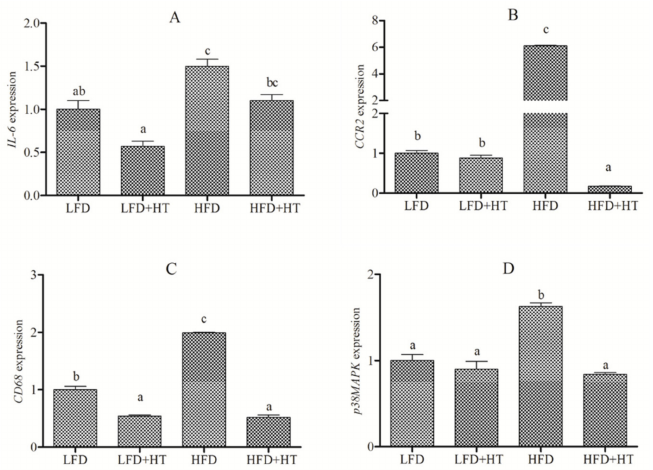
Figure 5. Relative expression of inflammation-related genes ( A ) IL-6 ( B ) CCR2 ( C ) CD68 ( D ) p38MAPK in the liver of blunt snout bream fed with experimental diets. Bars with different letters are signifi- cantly different ( p < 0.05).